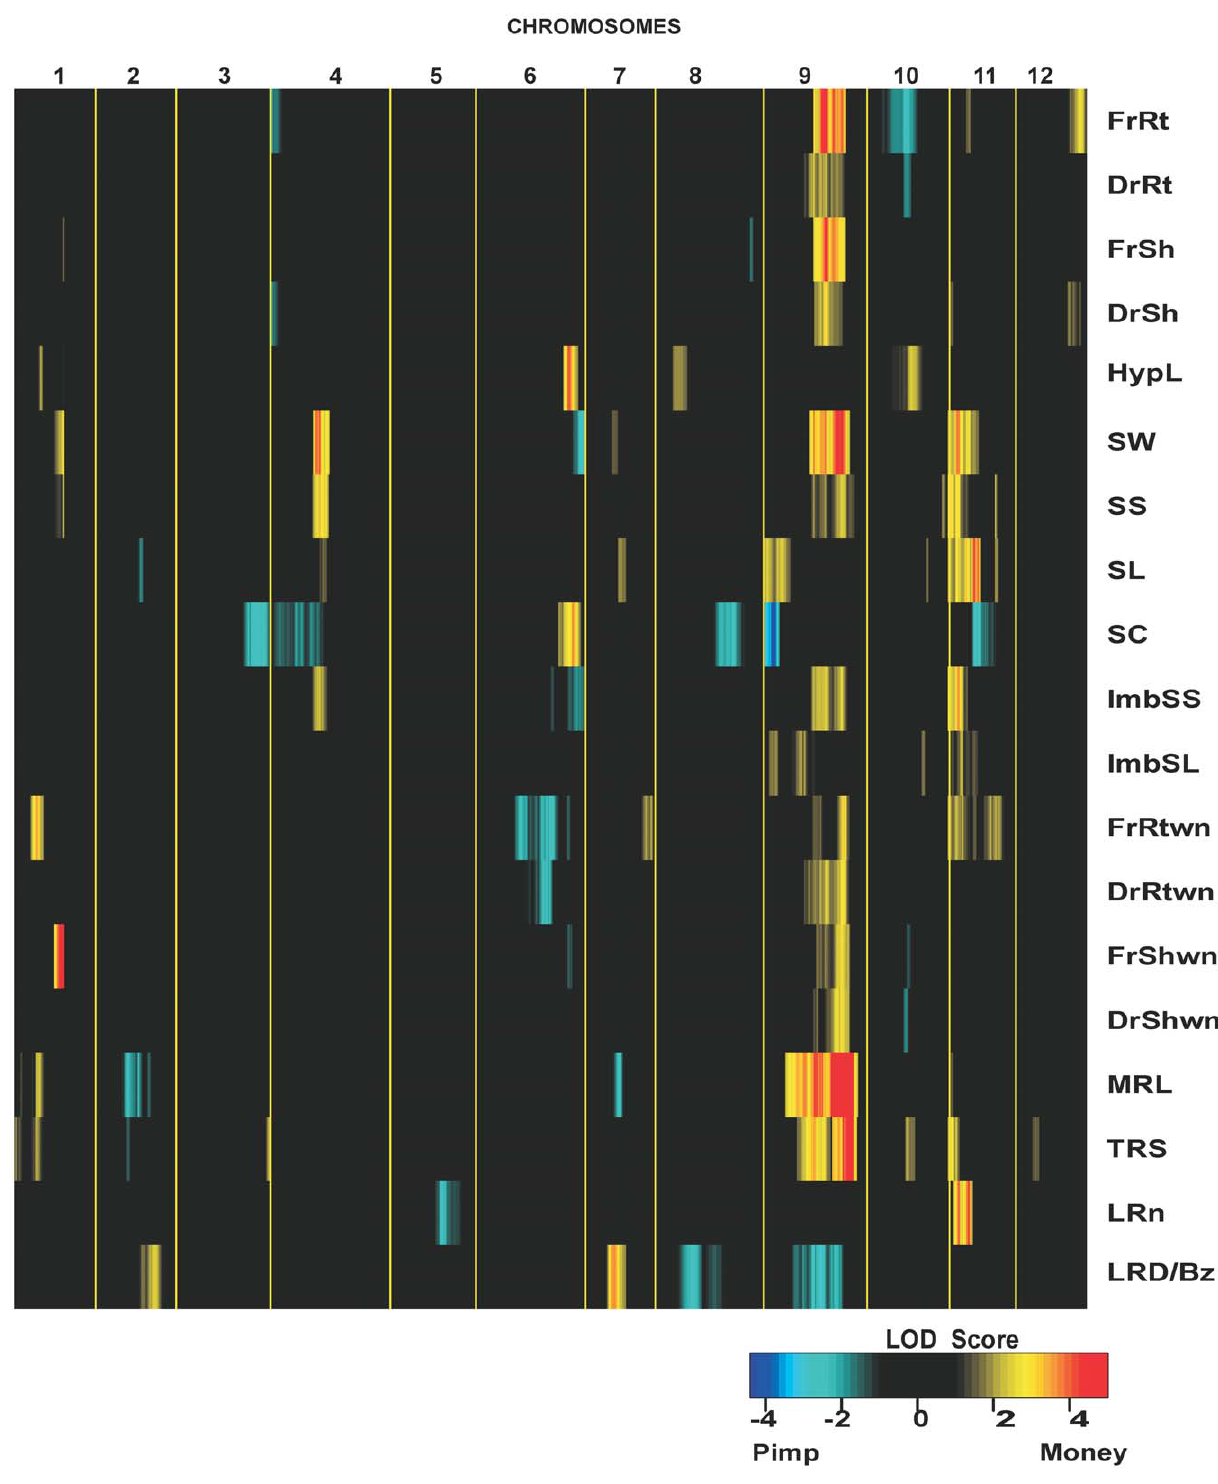
Figure 3. Heatmap of QTLs identified for seed and seedling quality traits. Tomato chromosomes are identified by numbers (1–12), with centimorgans ascending from the left to right; chromosomes are separated by yellow lines. SW=Seed Weight, SS=Seed Size SL=Seed Length. FrRt=Fresh Root weight, DrRt=Dry Root weight, FrSh=Fresh Shoot weight, DrSh Dry Shoot weight, FrShwn=Fresh Shoot weight in nutrientless conditions, DrShWn=Dry Shoot weight in nutrientless conditions, FrRtwn=Fresh Root weight in nutrientless conditions, DrRtwn=Dry Root weight in nutrientless conditions, MRL=Main Root Length, TRS=Total Root Size, LRn=Lateral Root number per main root, LRD/Bz=Lateral Root Density per Branched zone. Colors indicate QTLs significant at P =0.002 in multiple QTL mapping models (1-LOD intervals). Blue and light blue colors indicate a larger effect of the trait in S. pimpinellifolium , and yellow and red in S. lycopersicum .